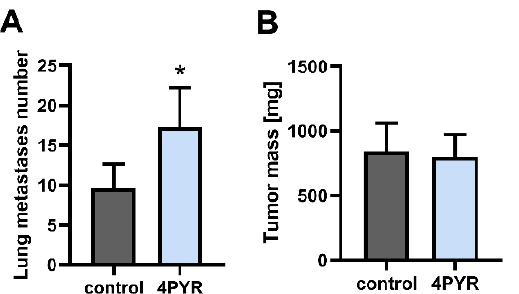
Figure 1. 4PYR increases lung metastasis formation but does not affect tumor growth in the 4T1 breast cancer model. The comparison between 4PYR-treated mice and saline-treated control in the number of lung metastases ( A ) and tumor mass ( B ). Lung metastases were analyzed in the 4T1 experimental metastasis model (1.5 × 10 4 of 4T1 cells injected intravenously), and tumor mass, in the 4T1 orthotopic model (3 × 10 5 of 4T1 cells injected into a mammary fad pad). Mice were euthanized 28 days after the injection of 4T1 cells. The number of surface metastatic loci was counted with a stereomicroscope, and confirmed using histological analysis. The tumor was weighted. In both models, 4PYR or the saline (control) was administered subcutaneously every 12 h (100 mg/kg/24 h) from the moment of the injection of the 4T1 cells. The graphs represent the mean ± SEM from two independent experiments, n = 10 per group. * p <